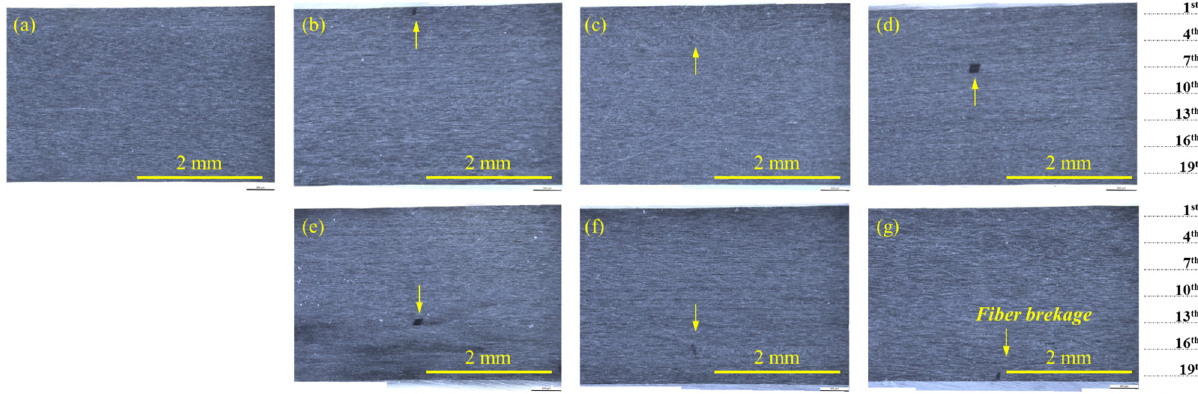
Figure 3: Cross - sections of CF/epoxy laminates with fiber breakage in different layers: ( a ) original, ( b ) first layer, ( c ) fourth layer, ( d ) seventh layer, ( e ) 13th layer, ( f ) 16th layer, and ( g ) 19th